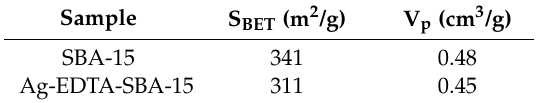
Figure 5. TEM images of ( a ) SBA-15; ( b ) EDTA-SBA-15; and ( c ) Ag-EDTA-SBA-15. Table 1. Surface and structural properties of synthesized mesoporous products.